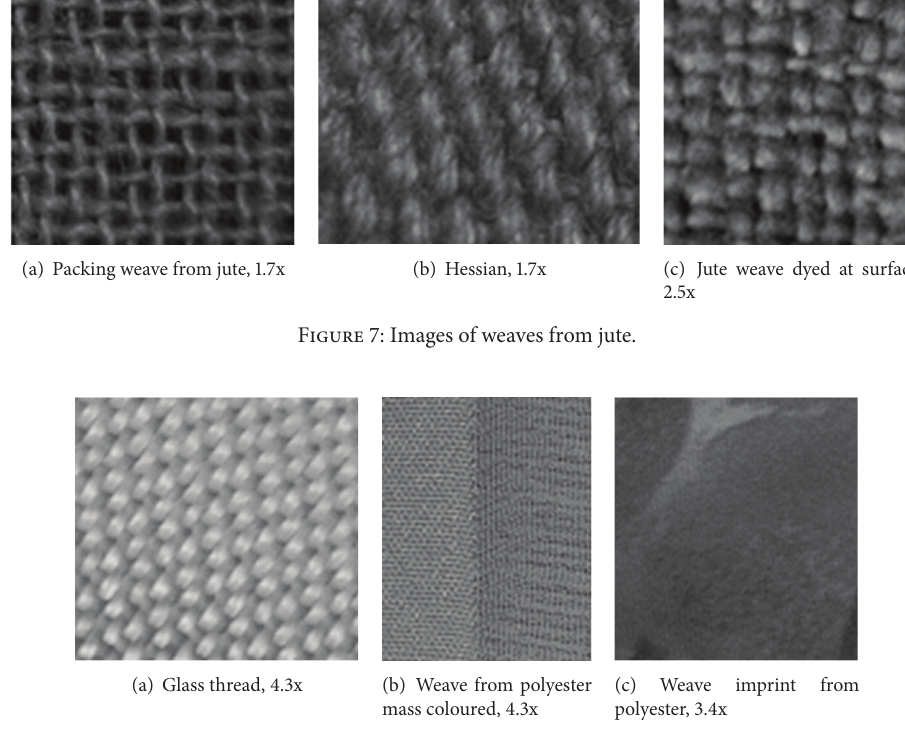
Figure 8: Images of weaves from glass thread or